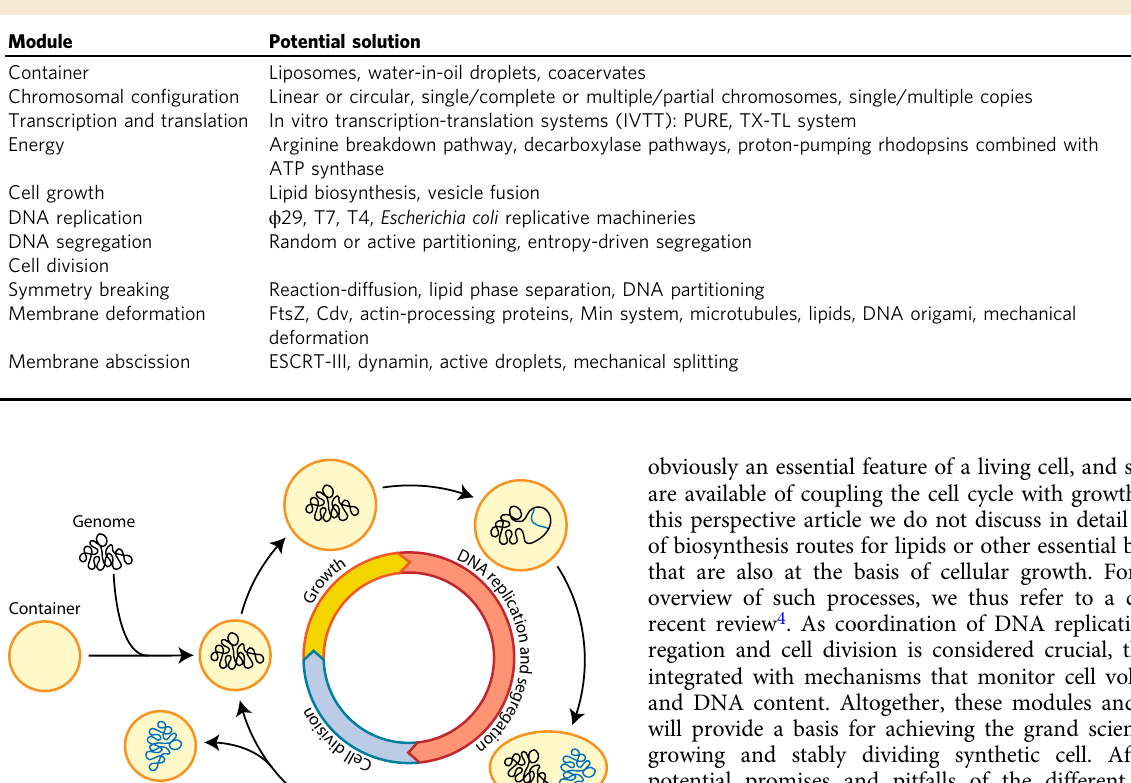
Table 1 Synthetic cell modules.